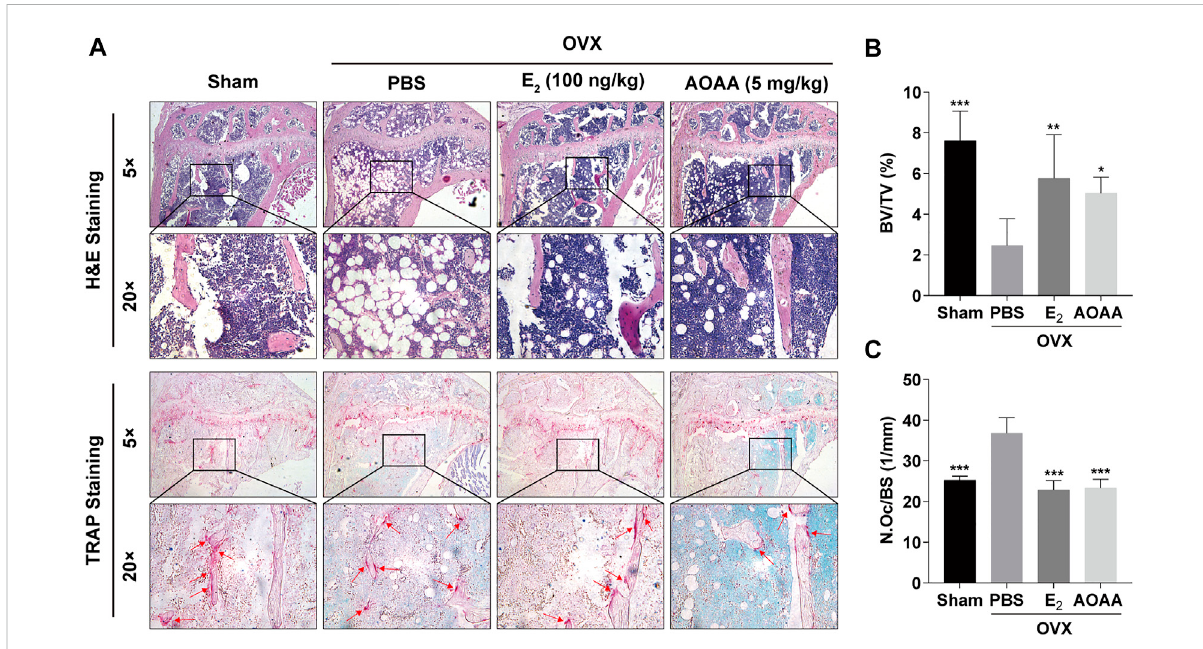
FIGURE 7 AOAA treatment reduces excessive osteoclastogenesis and resorption function in OVX mice. (A) Representative images of H&E and TRAP staining of decalci fi ed bone sections in each group. (B,C) Quantitative analyses of BV/TV and N. Oc/BS in tissue sections. All experimental data